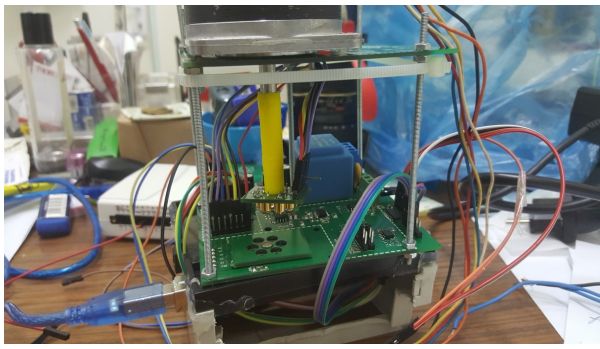
Fig. 6. Actual view of the self-designed optical